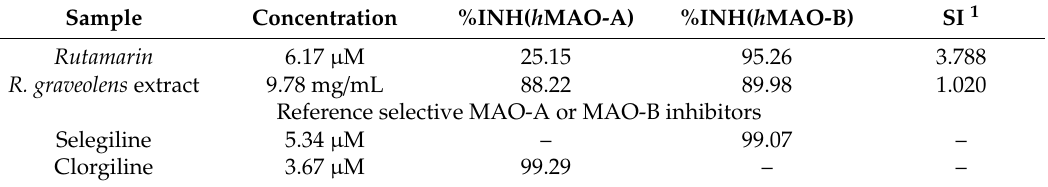
Table 1. Human monoamine oxidase ( h MAO)-inhibitory activities of rutamarin and R. graveolens L. dichloromethane